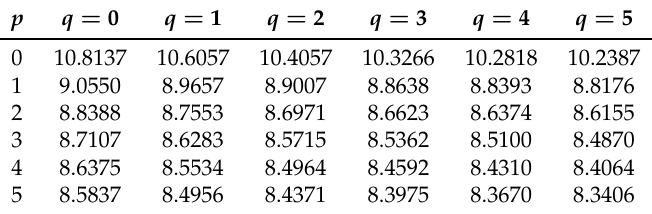
Table A2. Conditional entropies H ( p , q ) (bits/pixels), computed for various values of p and q , over “Gualtar”.